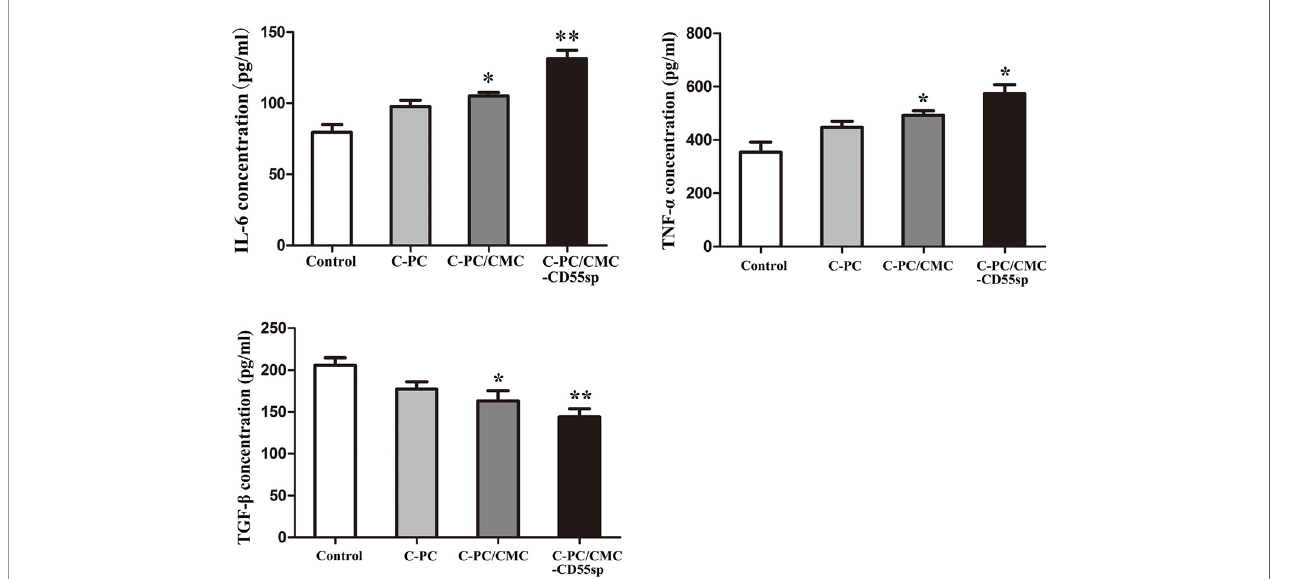
FIGURE 6 | Levels of interleukin-6 (IL-6), tumor necrosis factor- a (TNF- a ), and transforming growth factor b (TGF- b ) in nude mice. Enzyme-linked immunosorbent assay. The vertical axis represents concentration (pg/ml). Results are expressed as the mean ± SEM (n = 3). *P<0.05, **P<0.01.